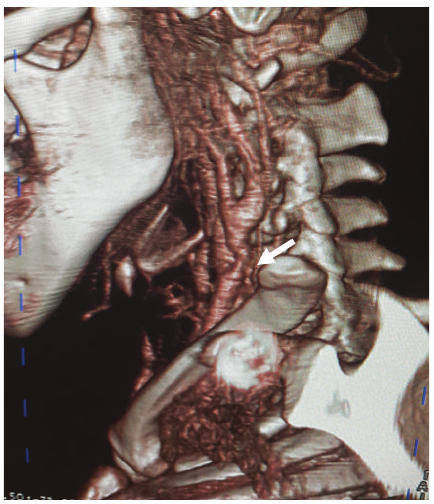
Figure 2: VRT CT picture at one-year follow-up. The common carotid is permeable without any residual dilation, with some mild scar narrowing at the anastomotic site (white